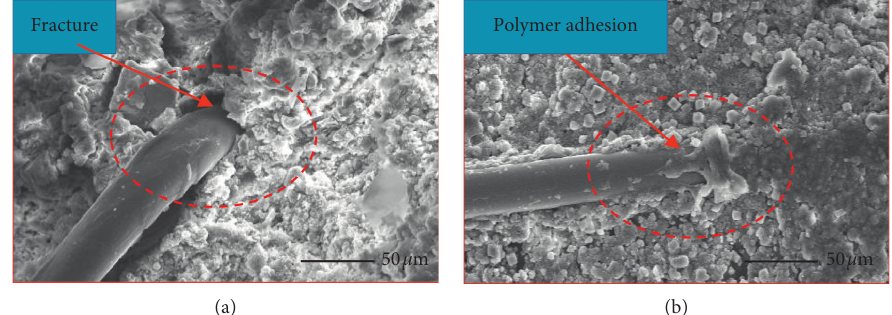
Figure 11: Material fiber attachment. (a) No polymer. (b) Polymer materials.